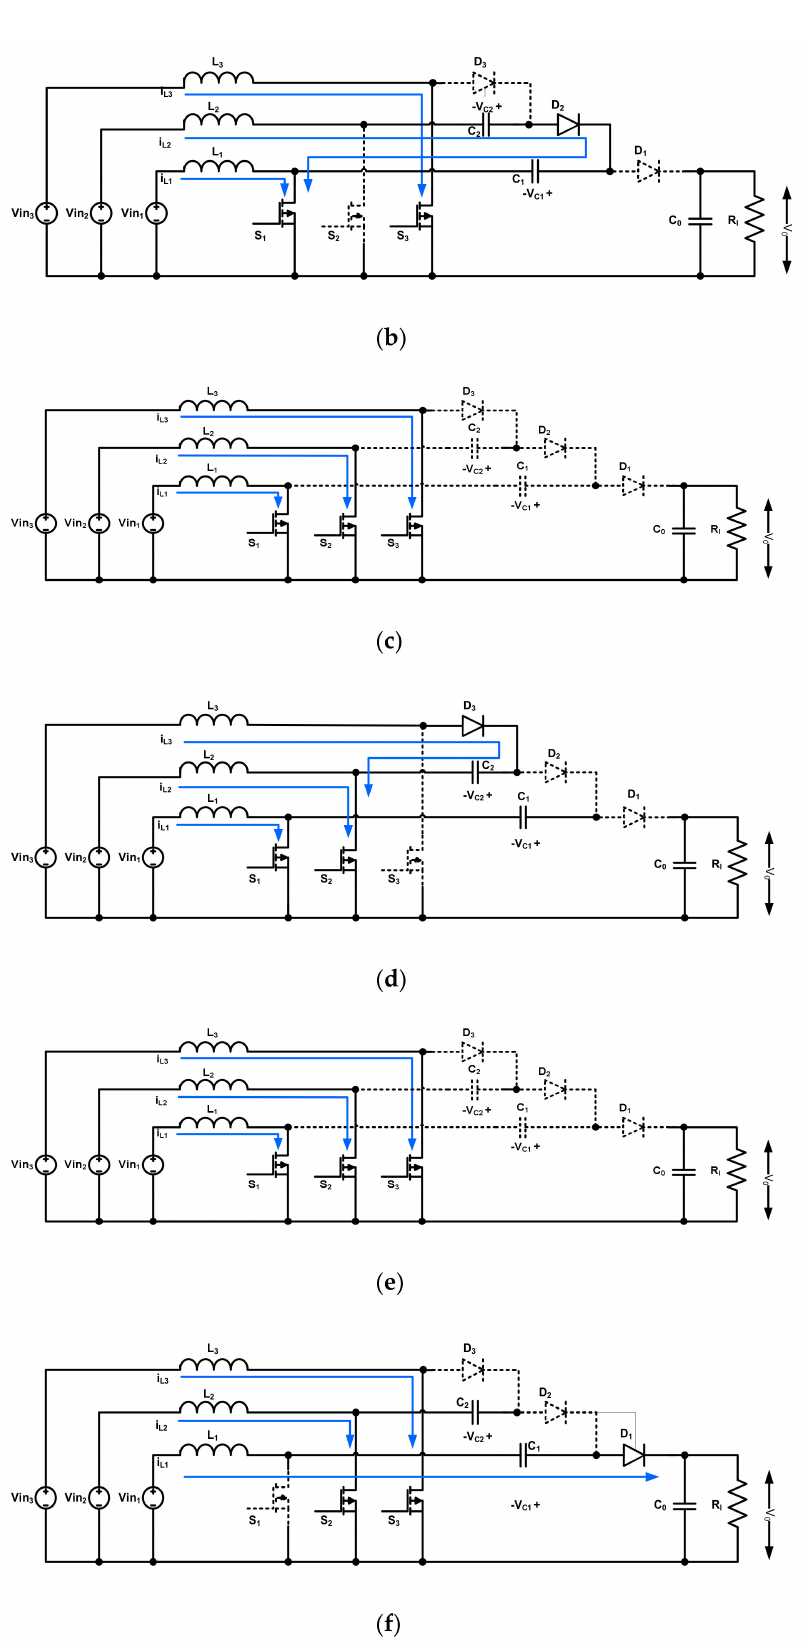
Figure 1. Operating modes of the three-input step-up converter: ( a ) Mode 1, S1 = S2 = S3 = On , ( b ) Mode 2, S1 = S3 = On , S2 = Off , ( c ) Mode 3, S1 = S2 = S3 = On , ( d ) Mode 4, S1 = S2 = On , S3 = Off , ( e ) Mode 5, S1 = S2 = S3 = On , ( f ) Mode 6, S2 = S3 = On , S1 =